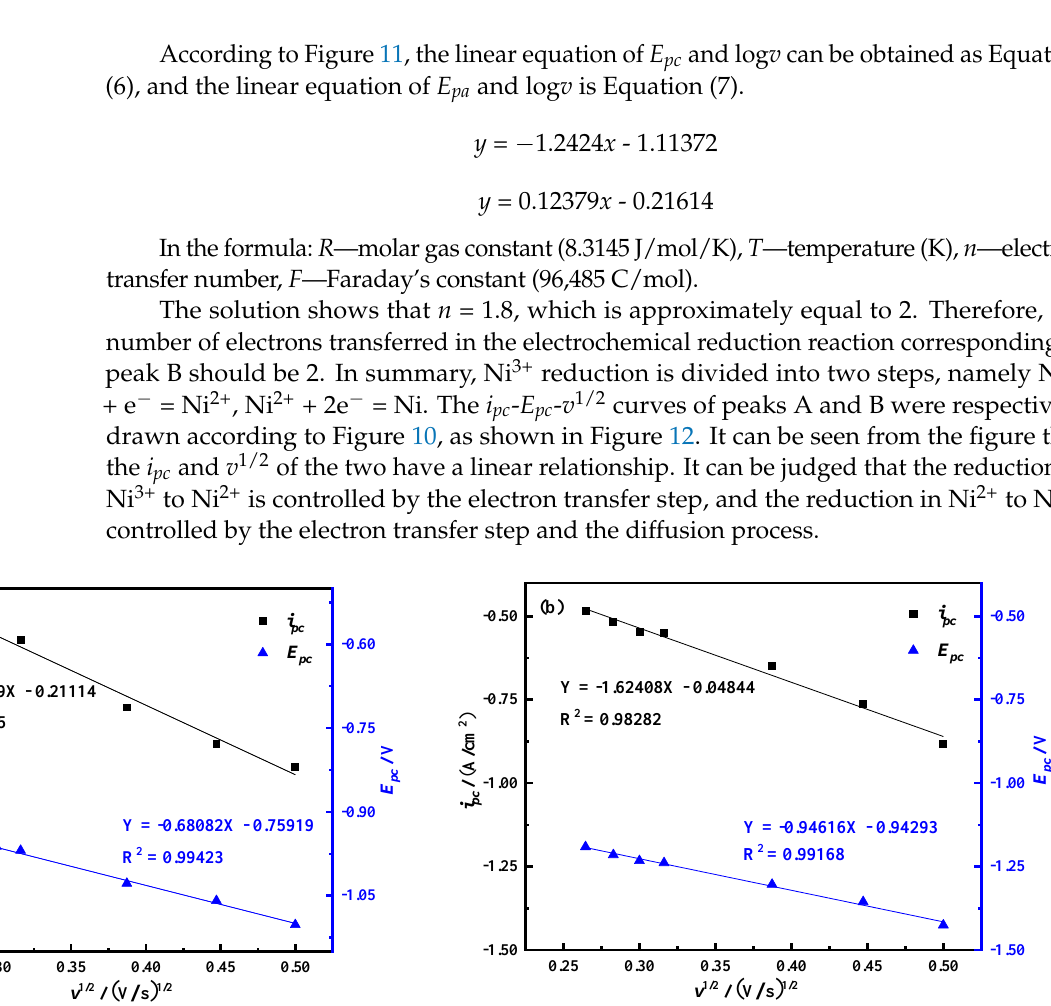
Figure 12. The i pc - v 1/2 and E pc - v 1/2 curves of reduction peaks A and B ( a ) peaks A ( b ) peaks B. 3.3. Preparation of Nickel by Electrolysis of LiNiO 2 with Molten Salt Constant Current Constant current electrolysis is used to study the reduction process of Ni, and its intermediate products, combined with the reaction process, the interface diffusion and transfer of Ni3+ reduction, are analyzed, and the reduction mechanism of Ni electrolysis is explored. The electrolysis mechanism diagram is shown in Figure 13. I have confirmed.